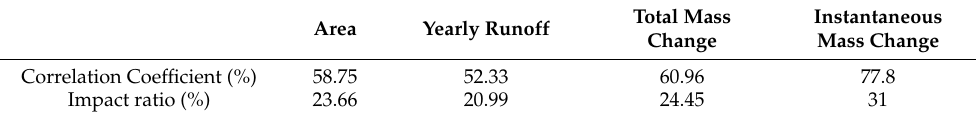
Table 20. Statistics on the degree of influence of different factors on Swarm-TWSC in 26 watersheds.